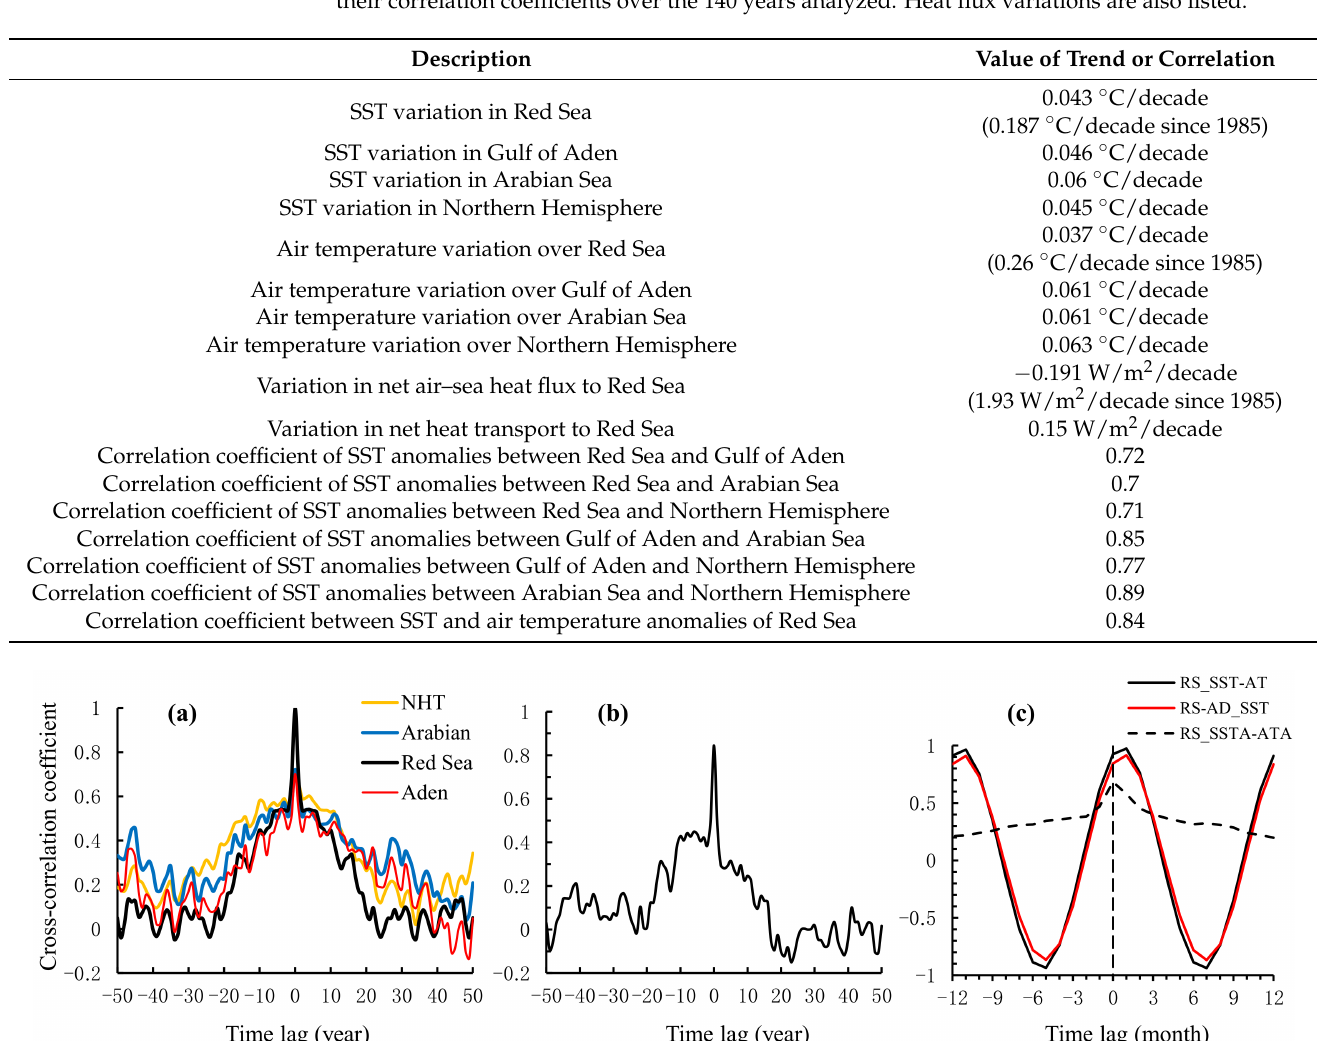
Table 1. The variation trends of SST and air temperature anomalies in Red Sea and adjacent seas and their correlation coefficients over the 140 years analyzed. Heat flux variations are also listed.